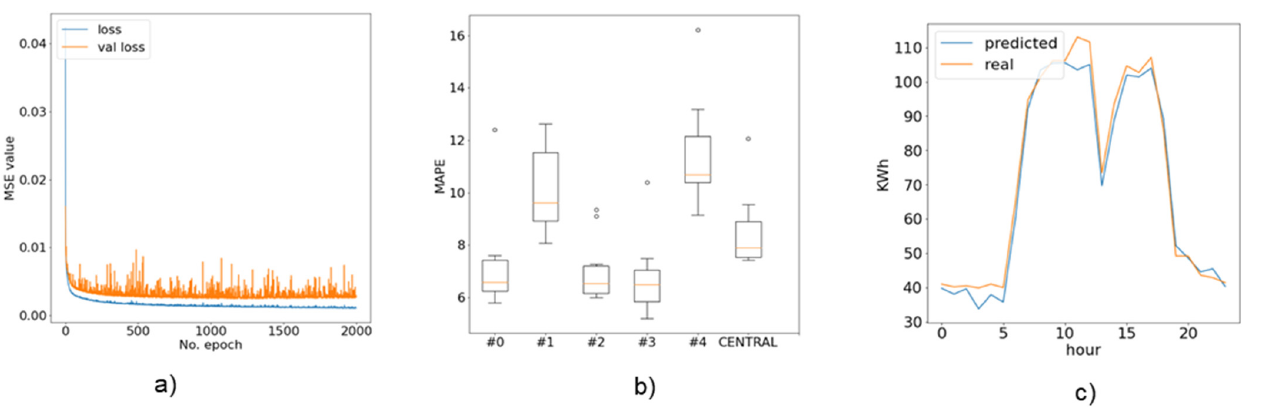
percentage error—MAPE 9.51) but features-limited privacy-preserving support due to data movement and centralization features.